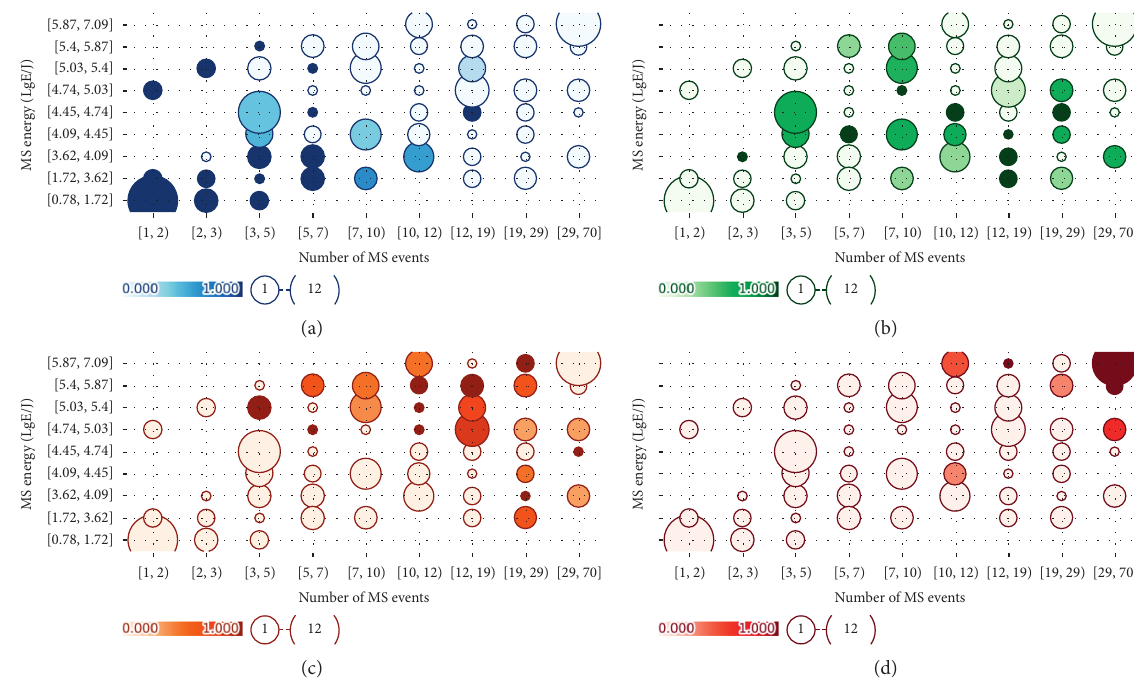
Figure 12: Interactive impact of the energy and events’ number of MS on rockburst. (a) Avereage no rockburst. (b) Avereage weak rockburst. (c) Avereage moderate rockburst. (d) Avereage strong